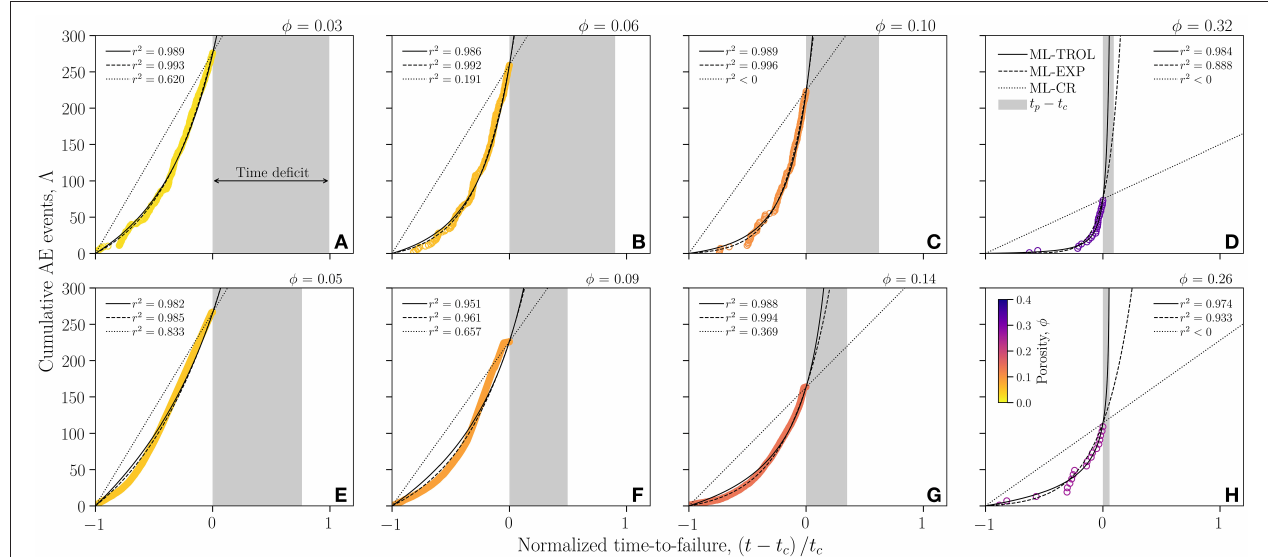
FIGURE 3 | The cumulative number of AE events as a function of normalized time. For comparison the best-fit power-law (ML-TROL; Equation 8), exponential (ML-EXP; Equation 7), and linear models (ML-CR; Equation 9) are given. (A–D) are for synthetic samples of variably sintered soda-lime-silica glass beads (Vasseur et al., 2013, 2015). (E–H) are for variably welded natural samples of Mt Meager deposits (Heap et al., 2014, 2015). Each panel represents a different porosity sample with low porosity on the left and high porosity on the right. The gray shaded boxes represent the time difference between the observed failure time (left margin of the box) and the failure time predicted by the extrapolated singularity of the ML-TROL power-law model (right margin of the box), such that the box itself represents the time-deficit in the forecast. All panels contain information about the coefficient of determination r 2 obtained for each fit. Adapted from Vasseur et al. (2017).